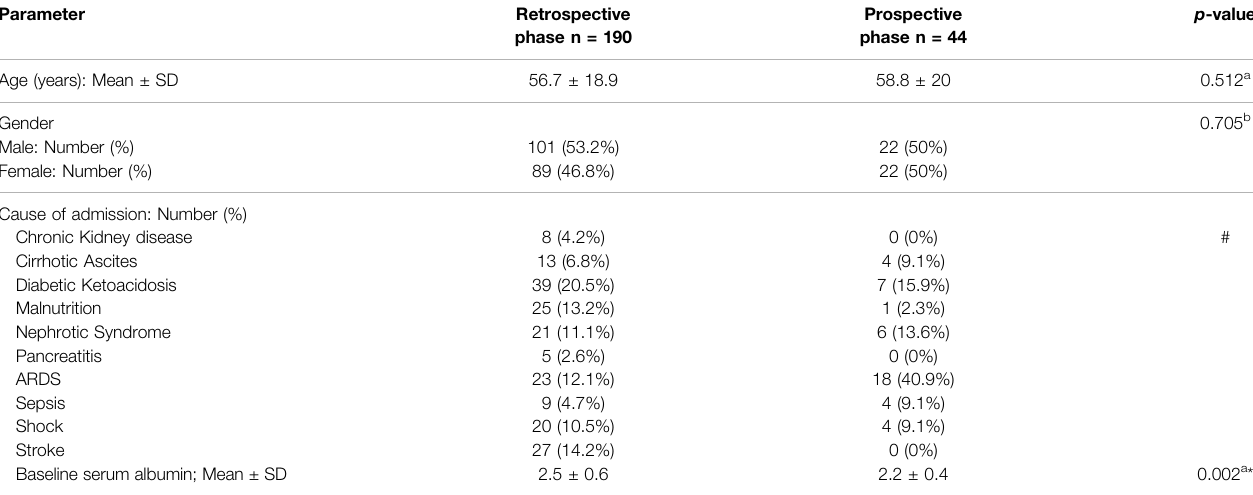
TABLE 1 | Baseline characteristics of the retrospective and prospective